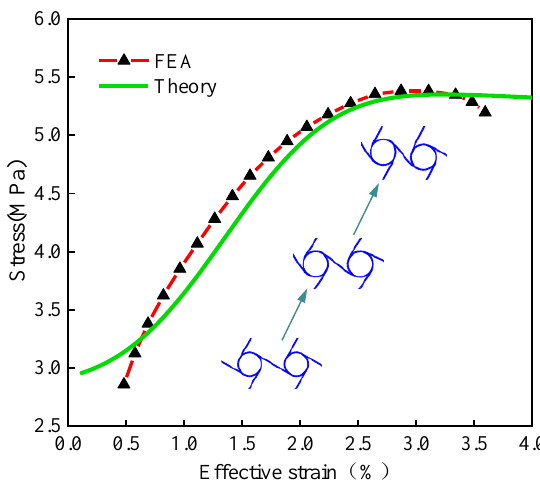
Figure 5. Effective strain-stress relationship curve for chiral metamaterials. (The length of the chiral ligament beam is 4 cm.)